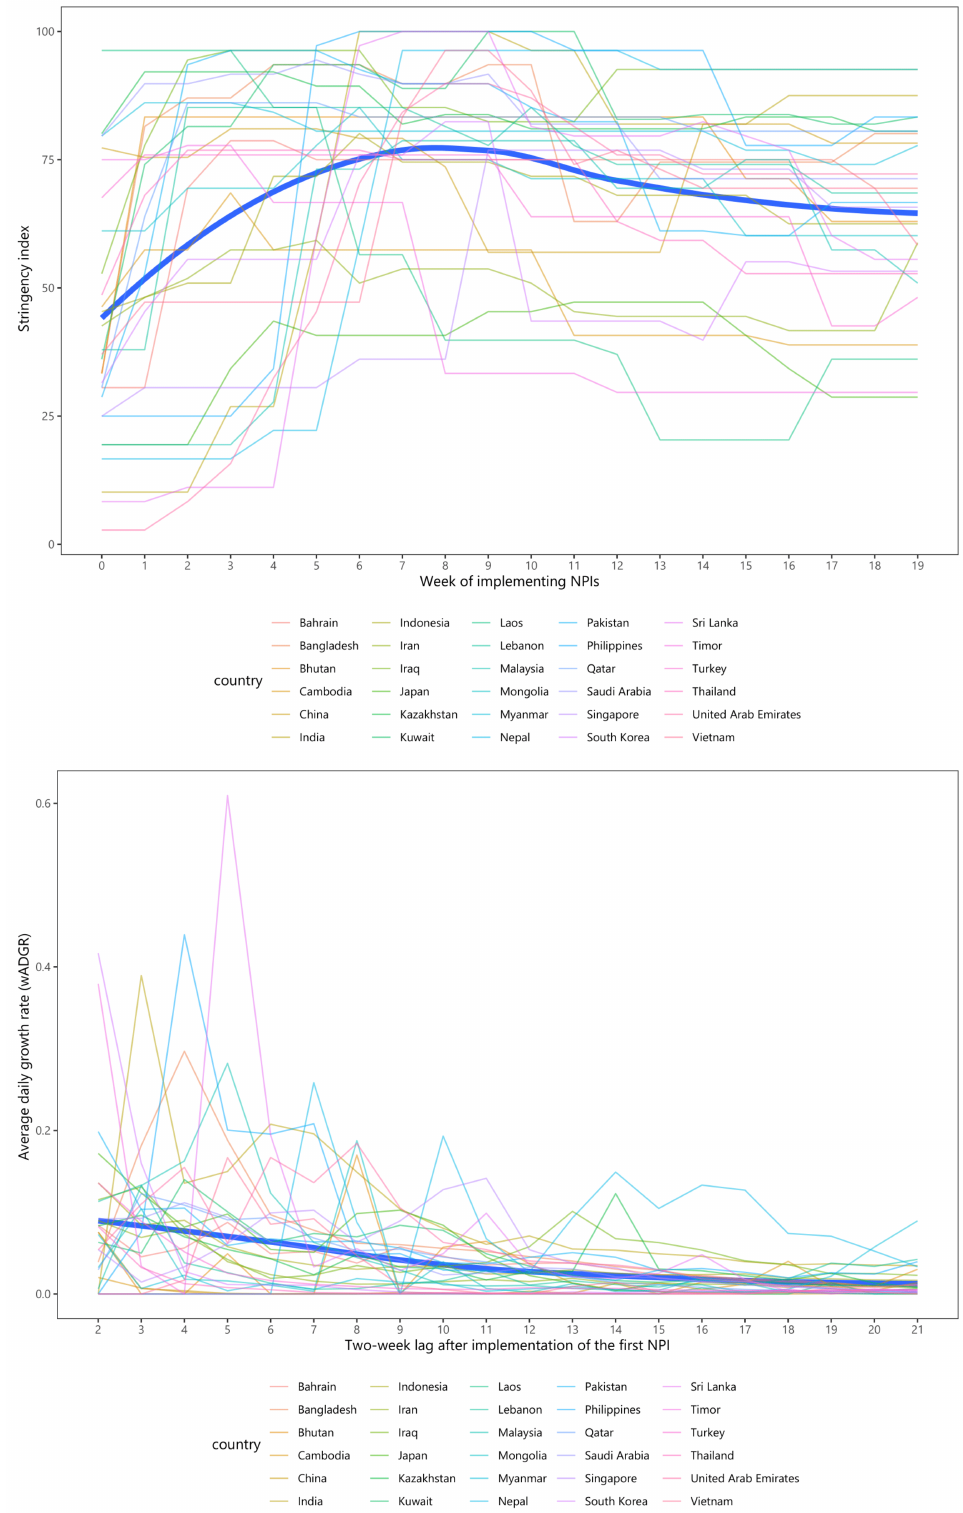
Figure 2. The evolution of stringency index and average daily growth rate (wADGR) over 20 weeks among Asian countries during the pre-vaccination